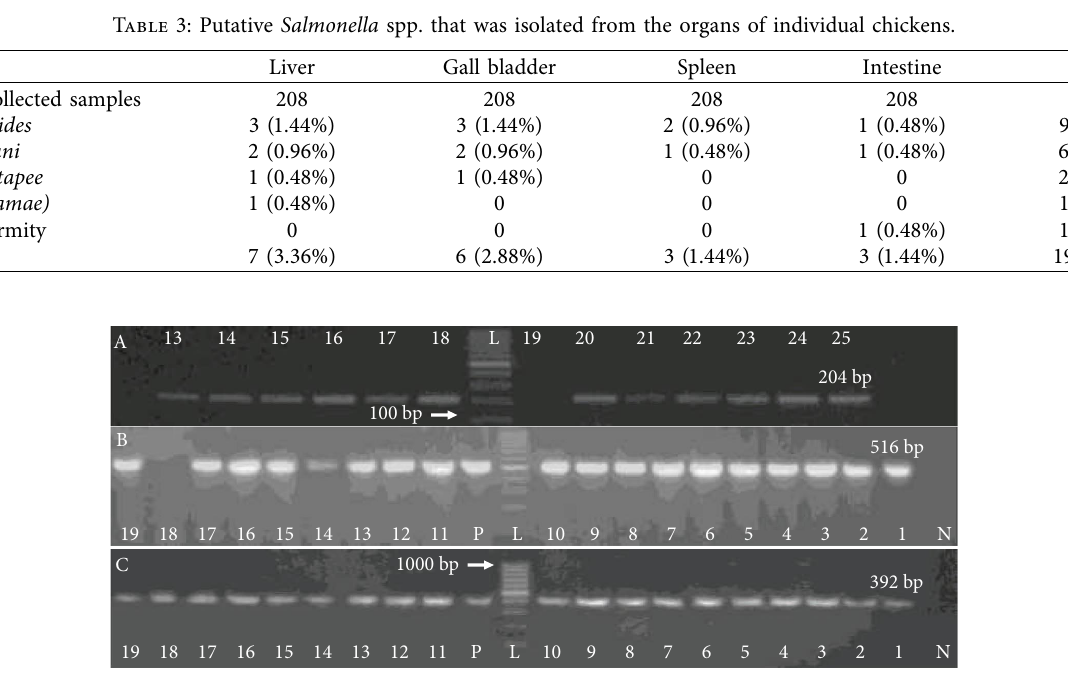
Figure 1: Salmonella spp. and beta-lactam resistance genes are diagnostic. PCR amplifcation of the (a) ompC (representative), the (b–c) β -lactam resistance genes bla TEM and bla SHV are found in Salmonella spp. Electrophoresis was carried out on a 1.5% agarose gel. Lane L 100bp DNA ladder, lane P for positive control, and lane N for negative control. Samples were run on a 1.5% TAE agarose gel.